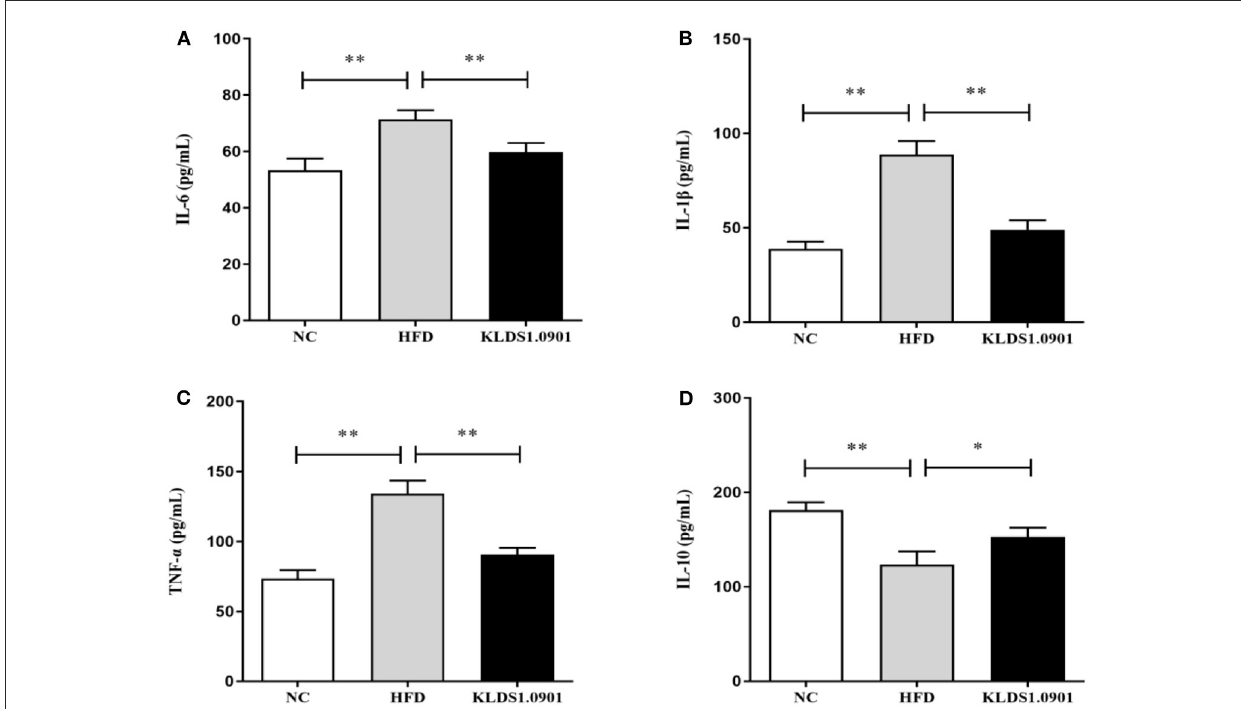
FIGURE5 Effects of L. acidophilus KLDS1.0901 administration on hepatic inflammation. NC, normal control group; HFD, high-fat diet group; and KLDS1.0901, L. acidophilus KLDS1.0901 group. (A) IL-6; (B) IL-1 β ; (C) TNF- α ; and (D) IL-10. Values are expressed as mean ± SD ( n = 8). * p < 0.05 and ** p < 0.01 indicated that there was a significant difference when compared with the HFD